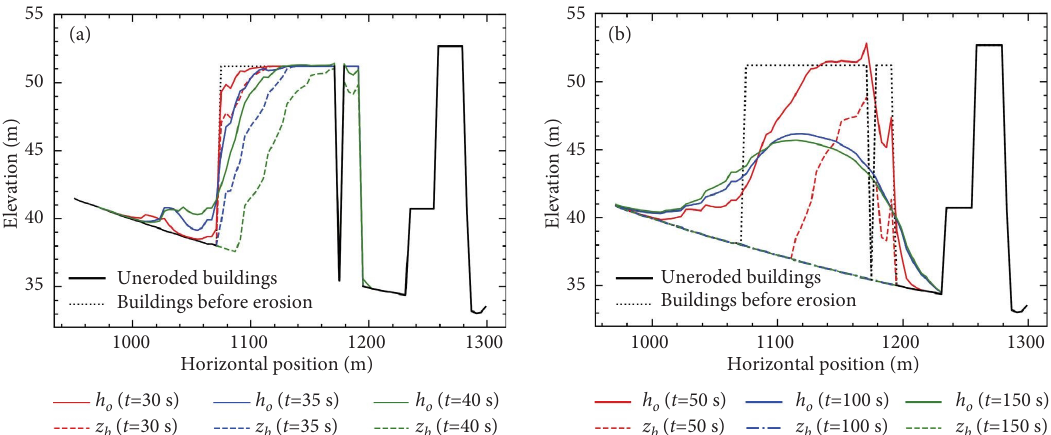
Figure 9: Te evolution characteristics of the erosion height and bed elevation on the profle section (along the yellow dashed line in Figure 6).